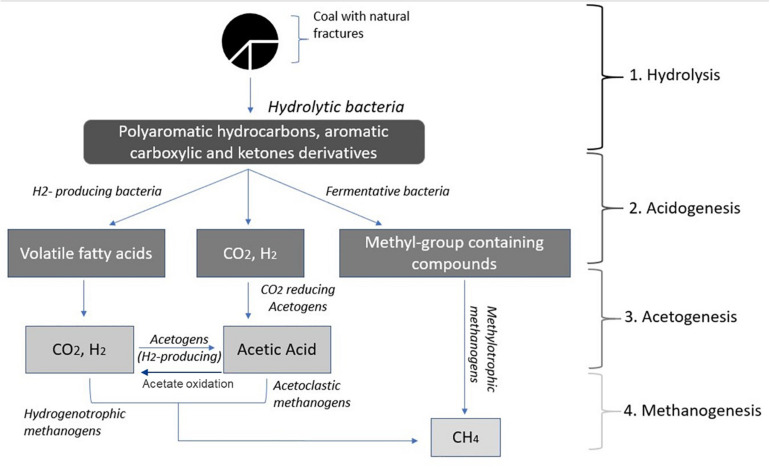
Conversion of coal into methane (adapted from Stra̧poć et al., 2008).